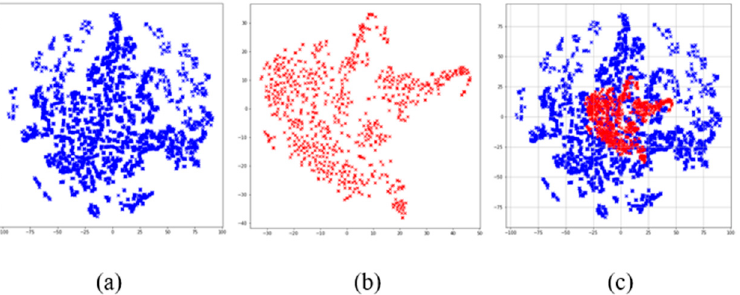
Figure 2. AD dataset t − SNE dimensionality reduction map. ( a ) The data distribution of non − AD patients after dimensionality reduction. ( b ) Data distribution of AD patients after dimensionality reduction. ( c ) The data distribution of non − AD and AD samples in the same space after dimensionality reduction.